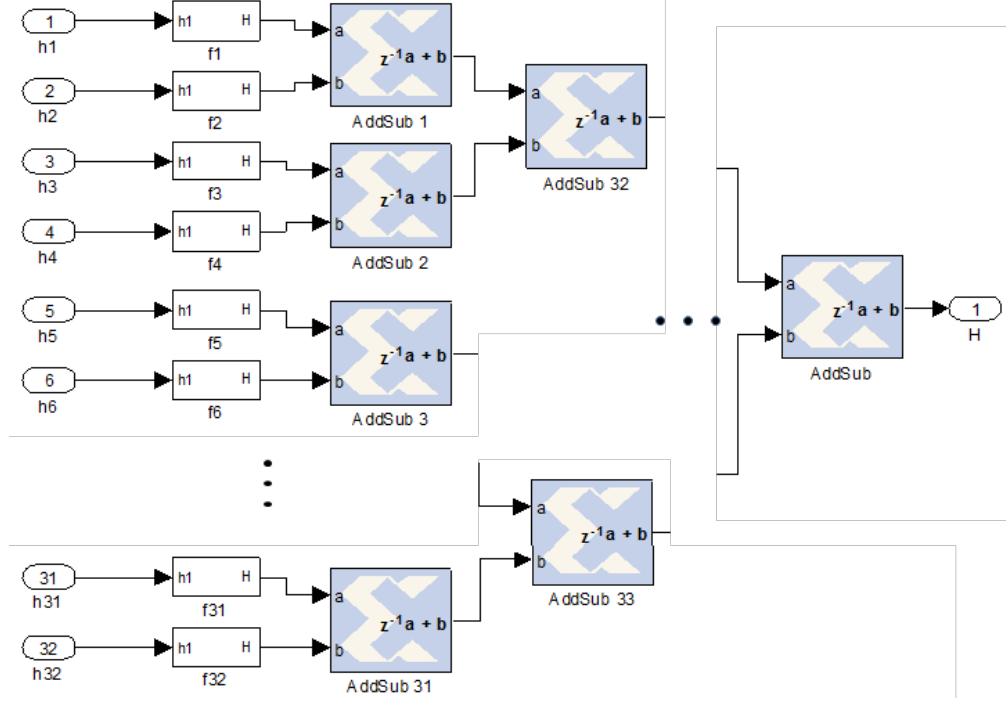
Figure 7. Entropy calculation from counter histogram ROI